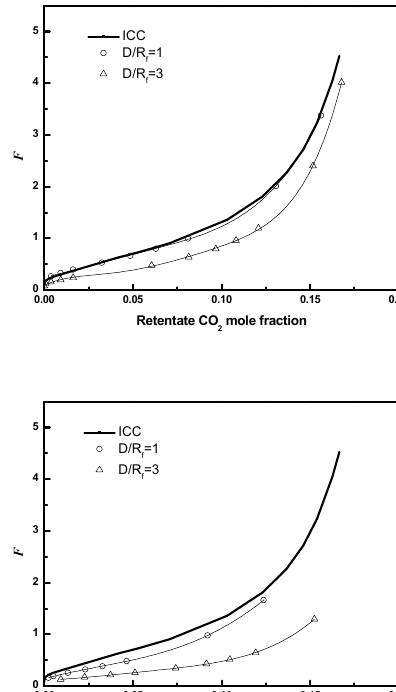
Figure 17. R or F as a function of CO 2 mole fraction for module with different packing fraction (3-